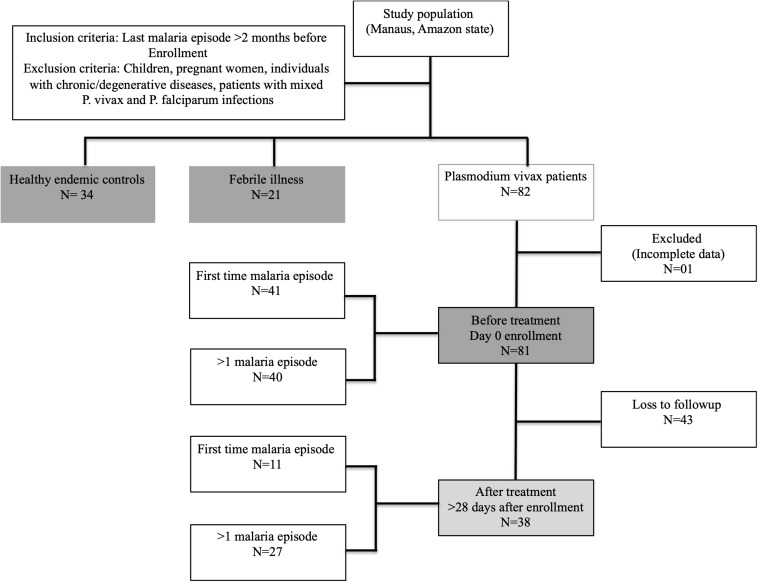
Sample collection flow chart (Strobe flow chart).